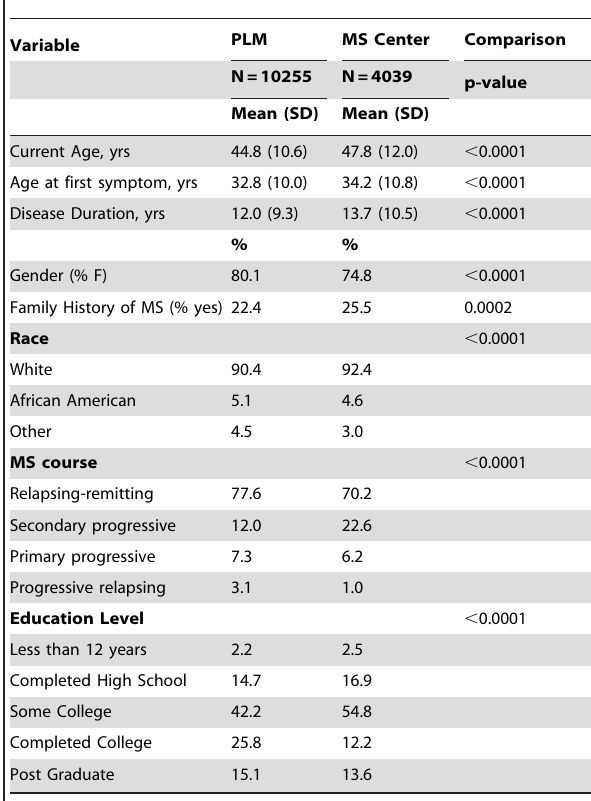
Table 1. Comparison of PLM members’ individual and disease characteristics with those of patients followed at the Partners MS